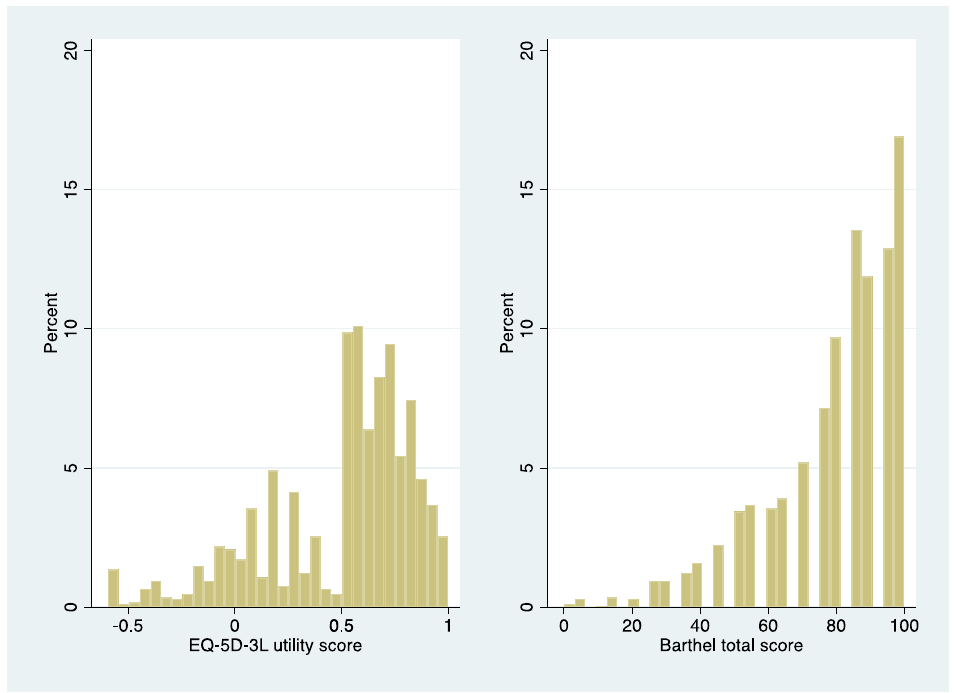
Figure 1. P resents the distribution of EuroQol 5 dimensions 3 levels (EQ-5D-3L) utilities and Barthel index (BI) total